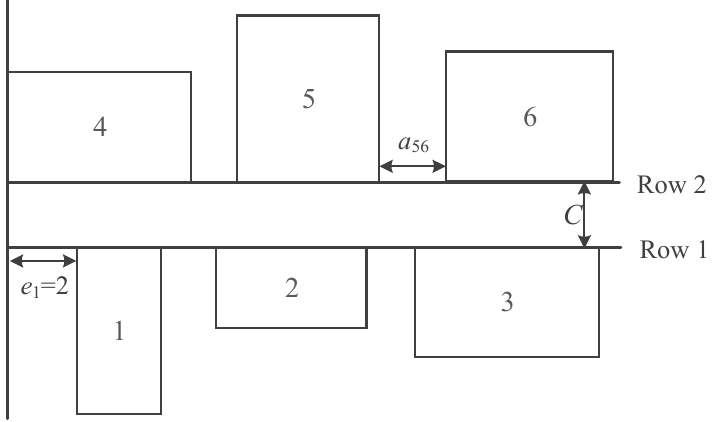
Figure 3. The decoding process for a coding ( π = {1, 2, 3, 4, 5, 6}, b = 3, o =